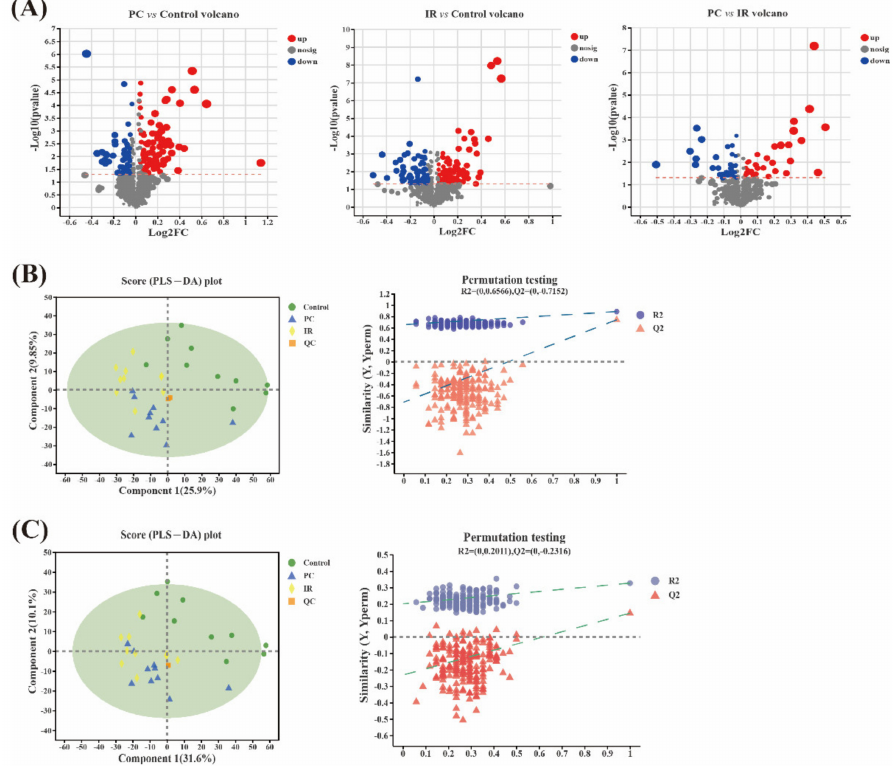
Figure 4. Metabolomic variation after PC or IR supplementation. ( A ) Volcano plot showing 144 variables that differ significantly between PC group and control group, 175 variables that differ significantly between IR group and control group, and 69 variables that differ significantly between PC group